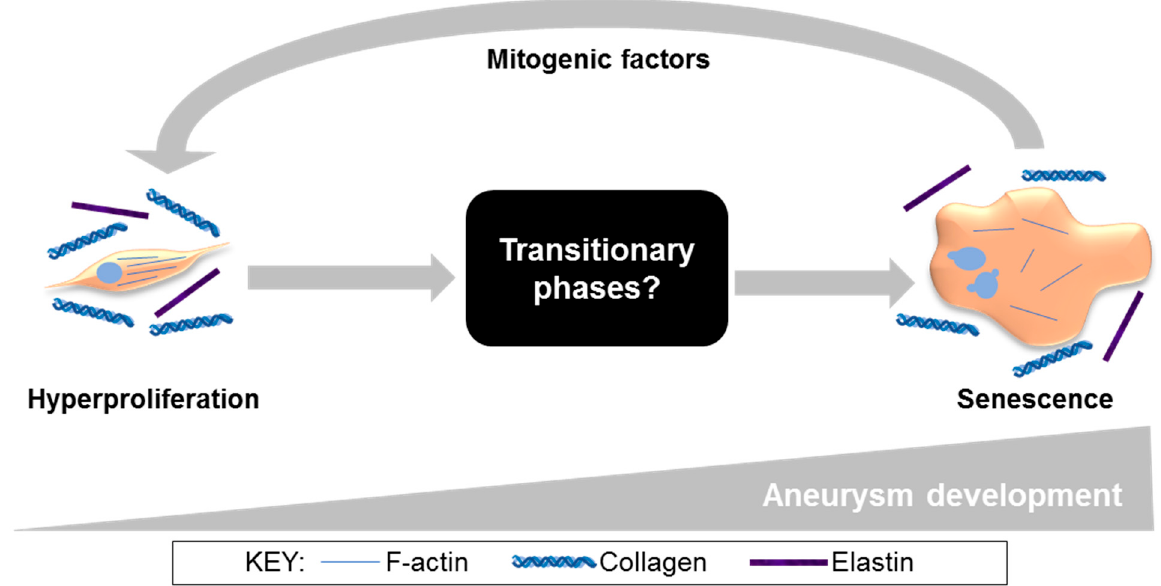
Figure 6. Our proposed model of aneurysm progression, specifically in SMC (from current and pub- lished studies) [23,33]. In the EARLY stages of aneurysm development, SMC are spindle-shaped and hyperproliferative. At the END stage, SMC have adopted a rhomboid morphology, disrupted actin cytoskeleton, and characteristics of senescence, secreting paracrine factors that induce proliferation in naïve SMC. Ultimately these mechanisms lead to irreversible SMC dysfunction and loss, vessel wall weakening, and increased risk of aneurysm